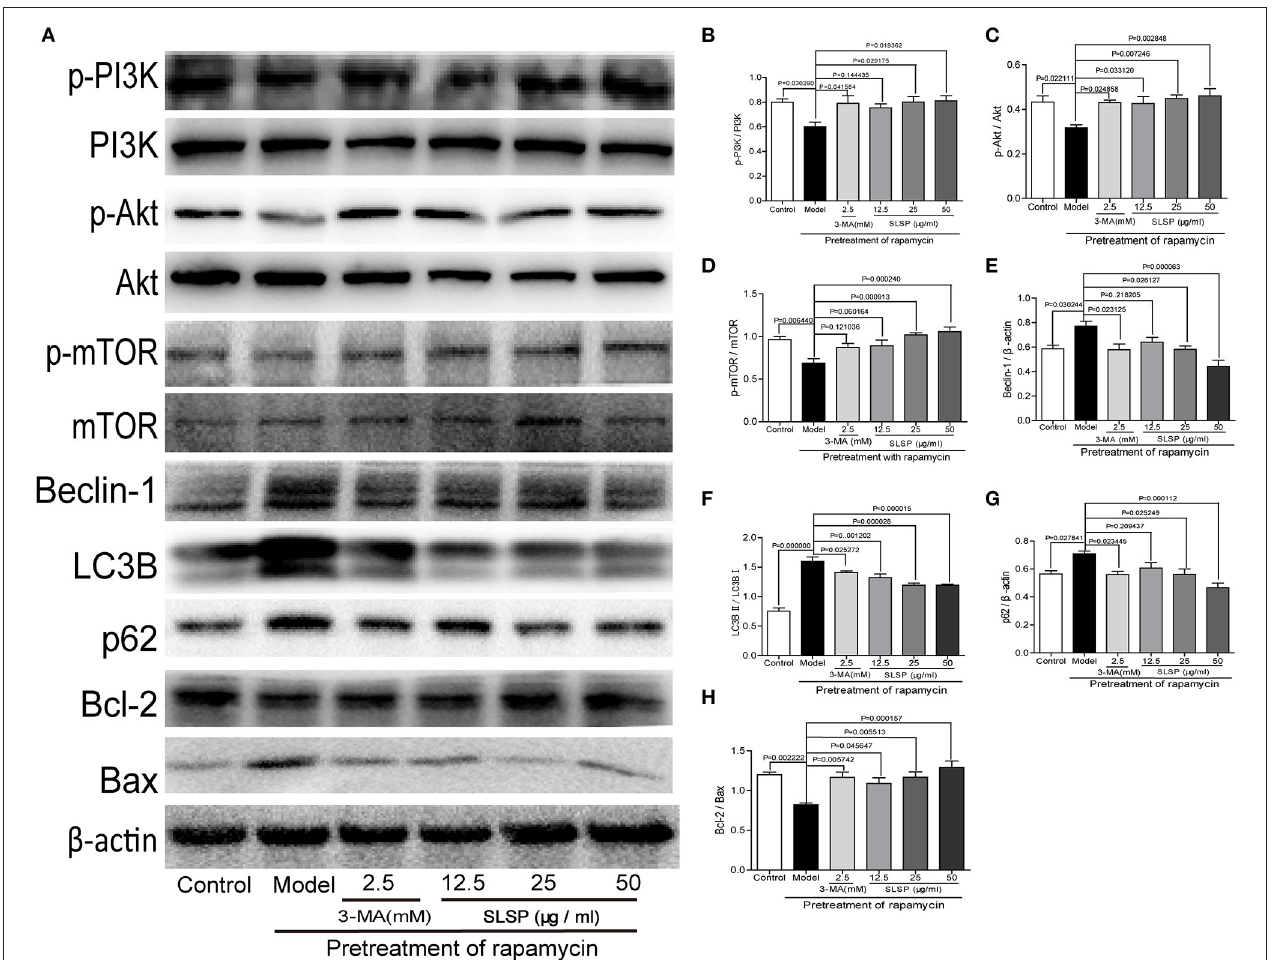
FIGURE 7 | SLSP inhibited the abnormal expressions of proteins related to autophagy and apoptosis in H9c2 cells pretreated with rapamycin. (A) Western blotting bands of related proteins in H9c2 cells. (B–H) Gray intensity analysis. N =